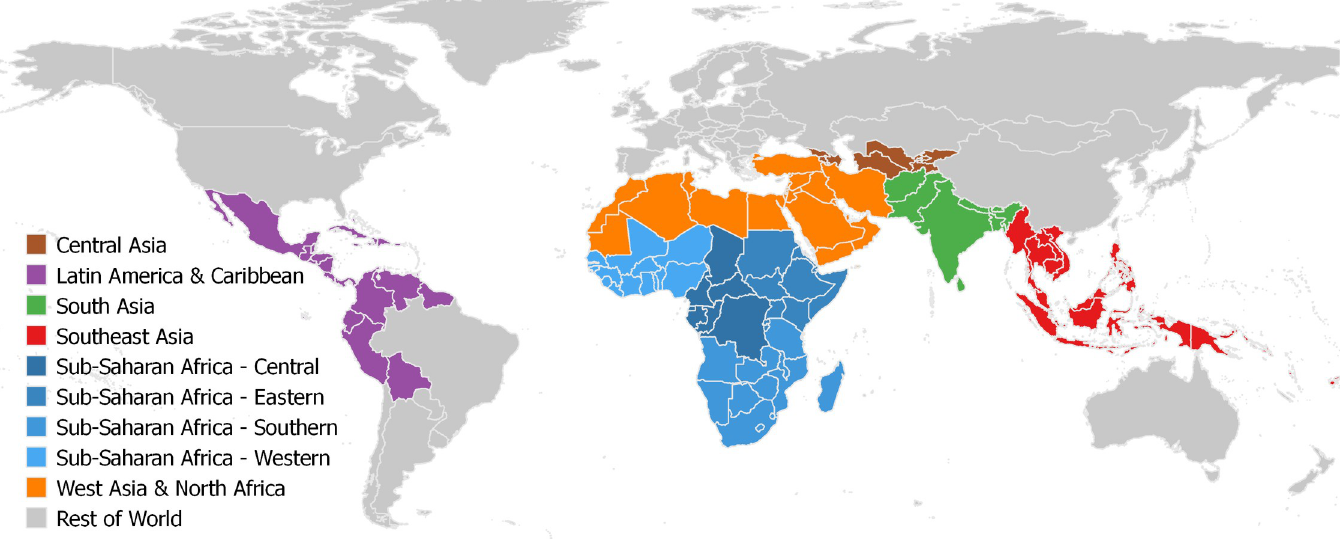
Fig 2. Countries and regions included in the analysis. The boundaries and names shown and the designations used on this map do not imply official endorsement or acceptance by the International Food Policy Research Institute (IFPRI). Source: The authors, using an adapted world country boundary map in the ArcWorld Supplement from ESRI, DeLorme Publishing Company, Inc. and created for display here using the free and open source QGIS [21].